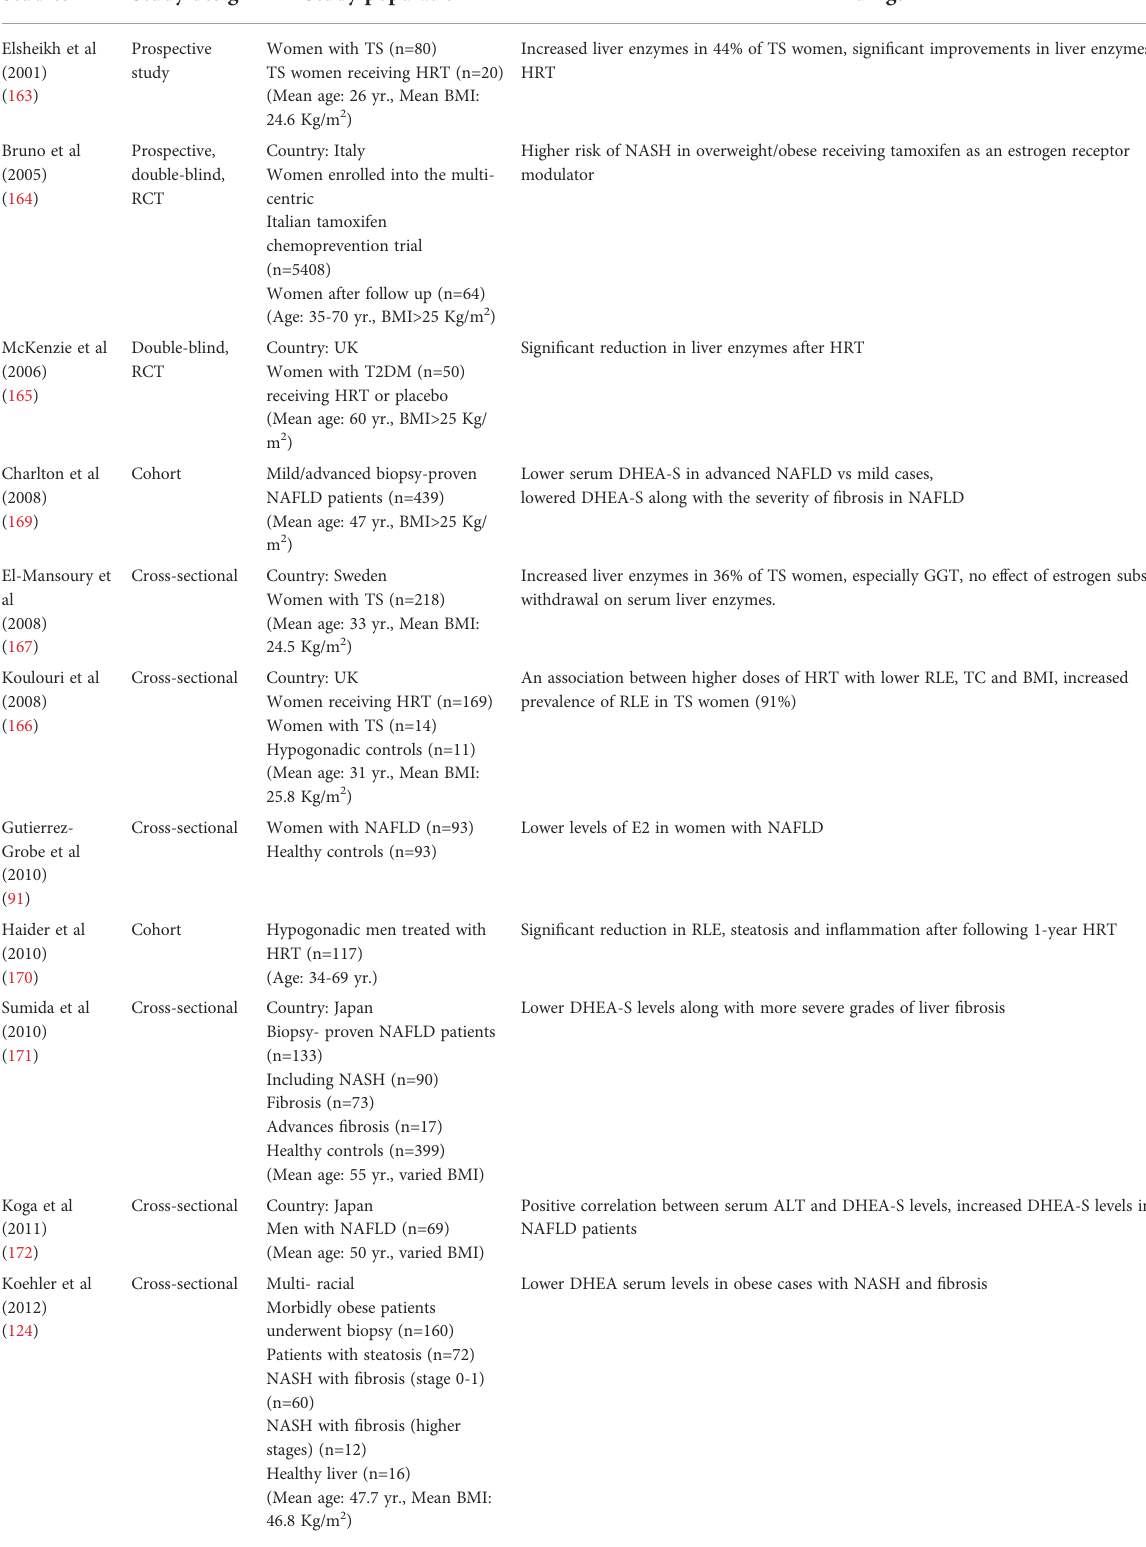
TABLE 3 Studies investigating the risk of NAFLD in